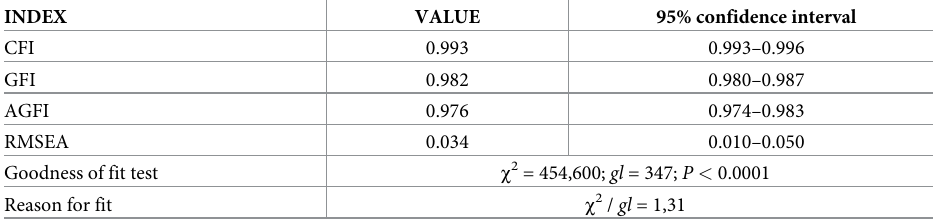
Table 5. Indices of goodness of fit of the exploratory factor analysis to the model for four dimensions the